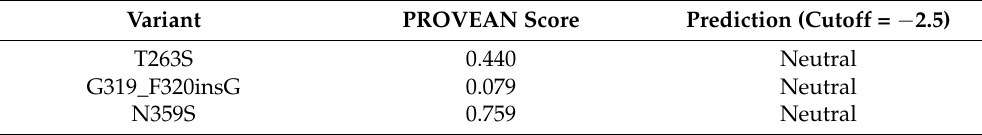
Table 1. Prediction of the significance of the detected amino acid substitutions for the functionality of the rye GRF3 protein using the PROVEAN online service.